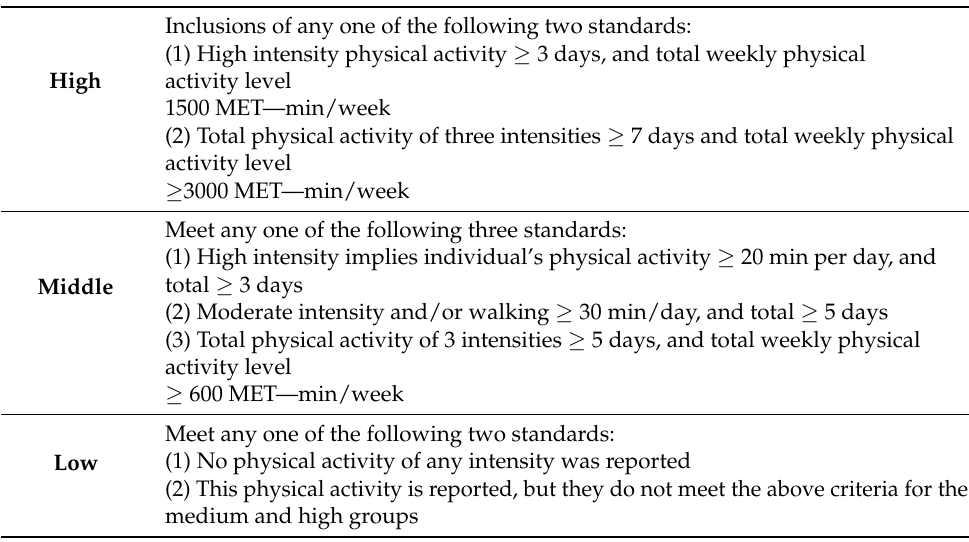
Table 1. Grouping criteria for individuals’ physical activity